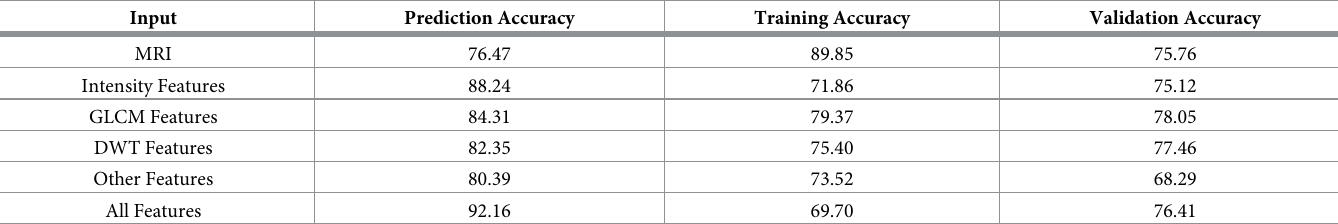
Table 8. Tumor/Non-tumor detection with image and image features.